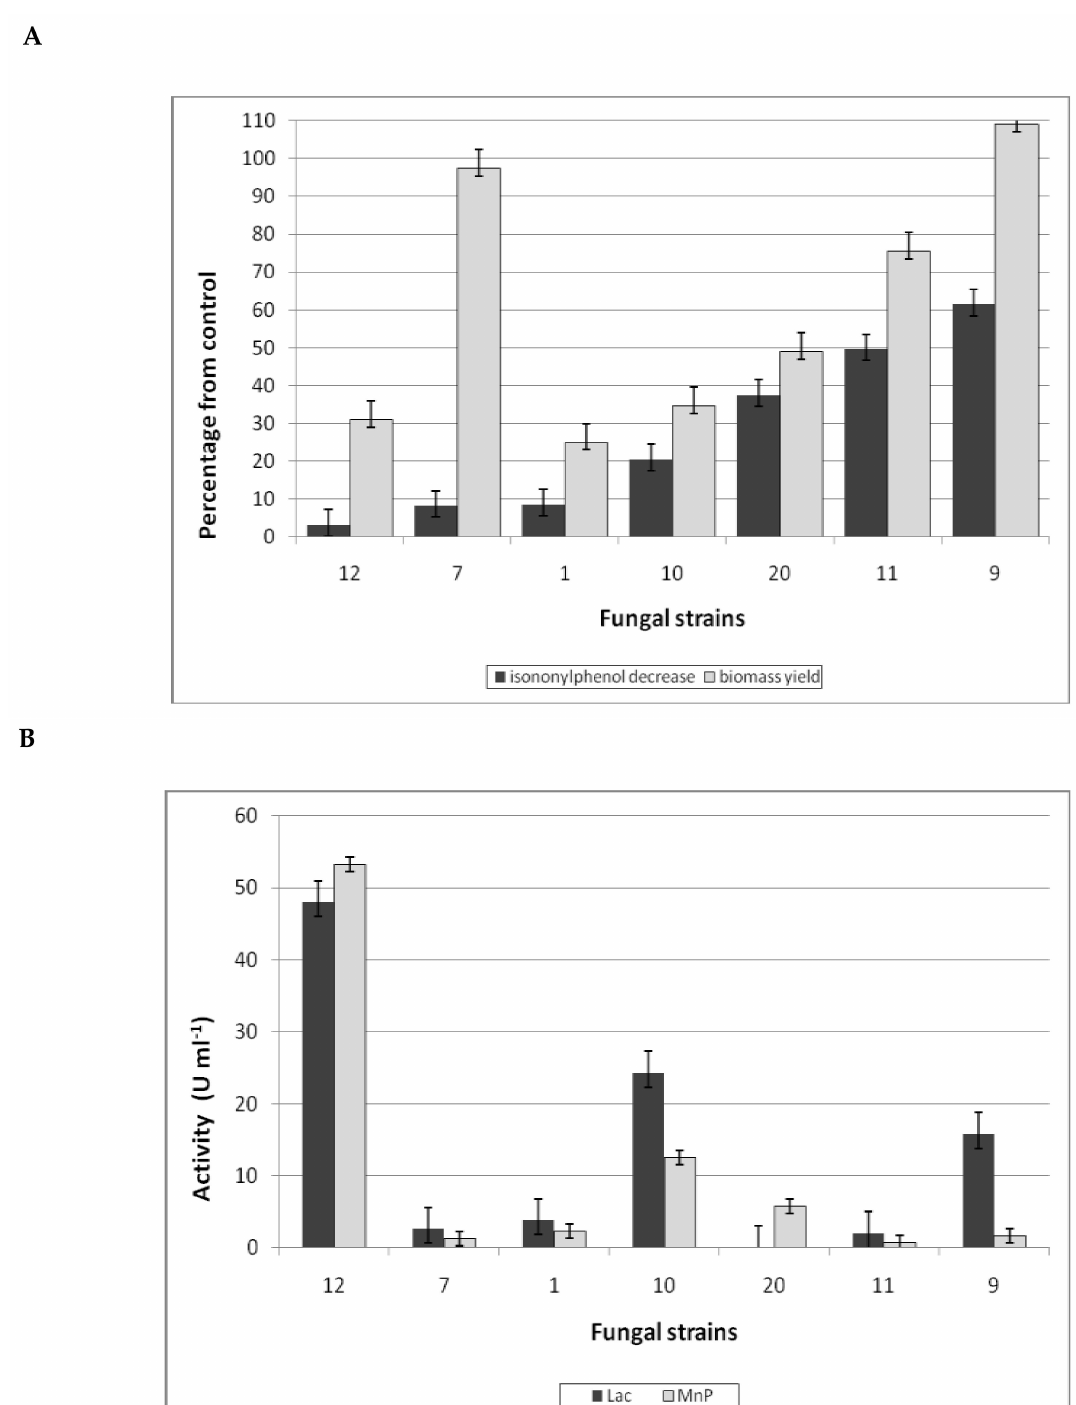
Figure 5. The isononylphenol disappearance and biomass yield ( A ) and ligninolytic enzymes produc- tion ( B ) during growth of studied fungi at the presence of isononylphenol: 1— P. ostreatus f. Florida, 7— L. betulina , 9— S. commune , 10— S. rugosoannulata , 11— T. versicolor DSM11372, 12— T. versicolor MUT3403, 20— C. herbarum